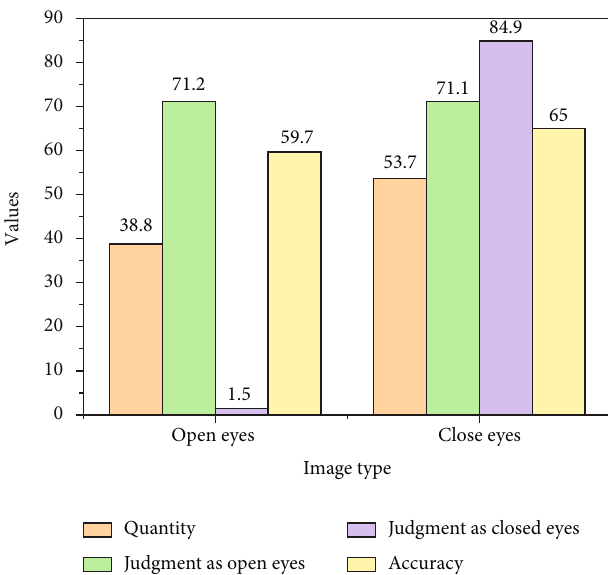
Figure 4: Partial eye network model classi fi cation.